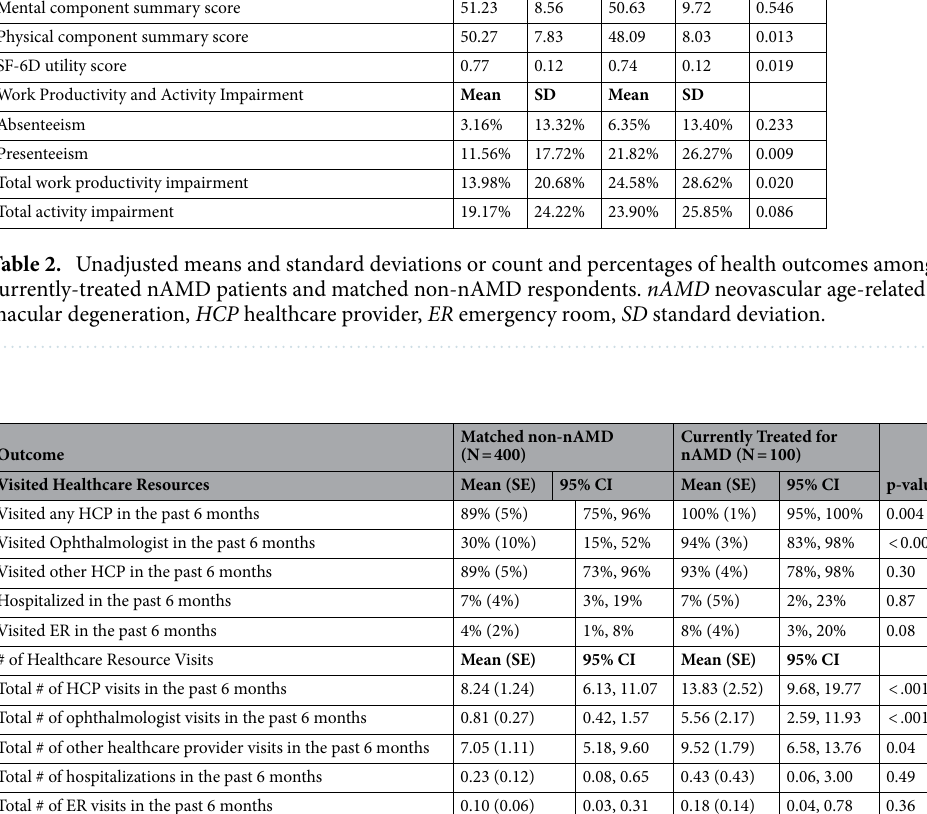
Table 3. Adjusted means with 95% CIs examining the effect of treated nAMD on healthcare resource visits and the number of visits after controlling for demographics and health characteristics among currently-treated nAMD patients and matched non-nAMD respondents. CI confidence interval, nAMD neovascular age-related macular degeneration, SE standard error, HCP healthcare provider, ER emergency room.